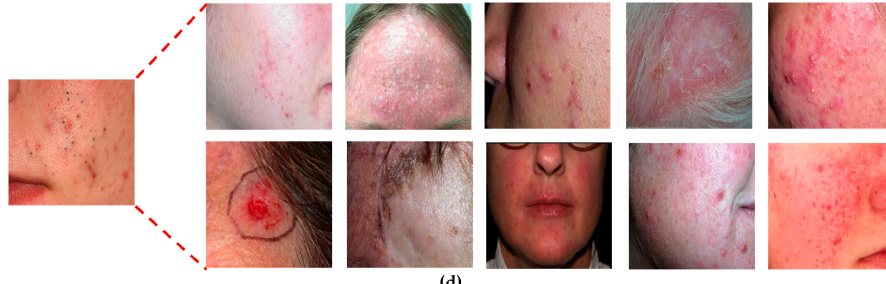
Figure 16. Examples of good retrieval performance of our proposed system for input query image. (a) colonography CT; (b) liver CT; (c) upper endoscopy; (d) facial acne.